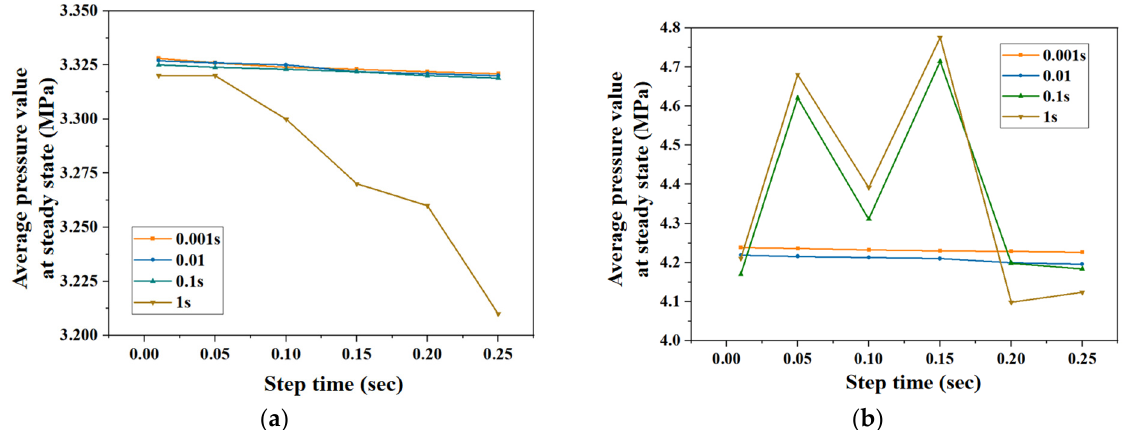
Figure 6. The time step sensitivity study: ( a ) relationship between maximum pressure and step time for oil erosion; ( b ) relationship between maximum pressure and step time for seawater erosion.